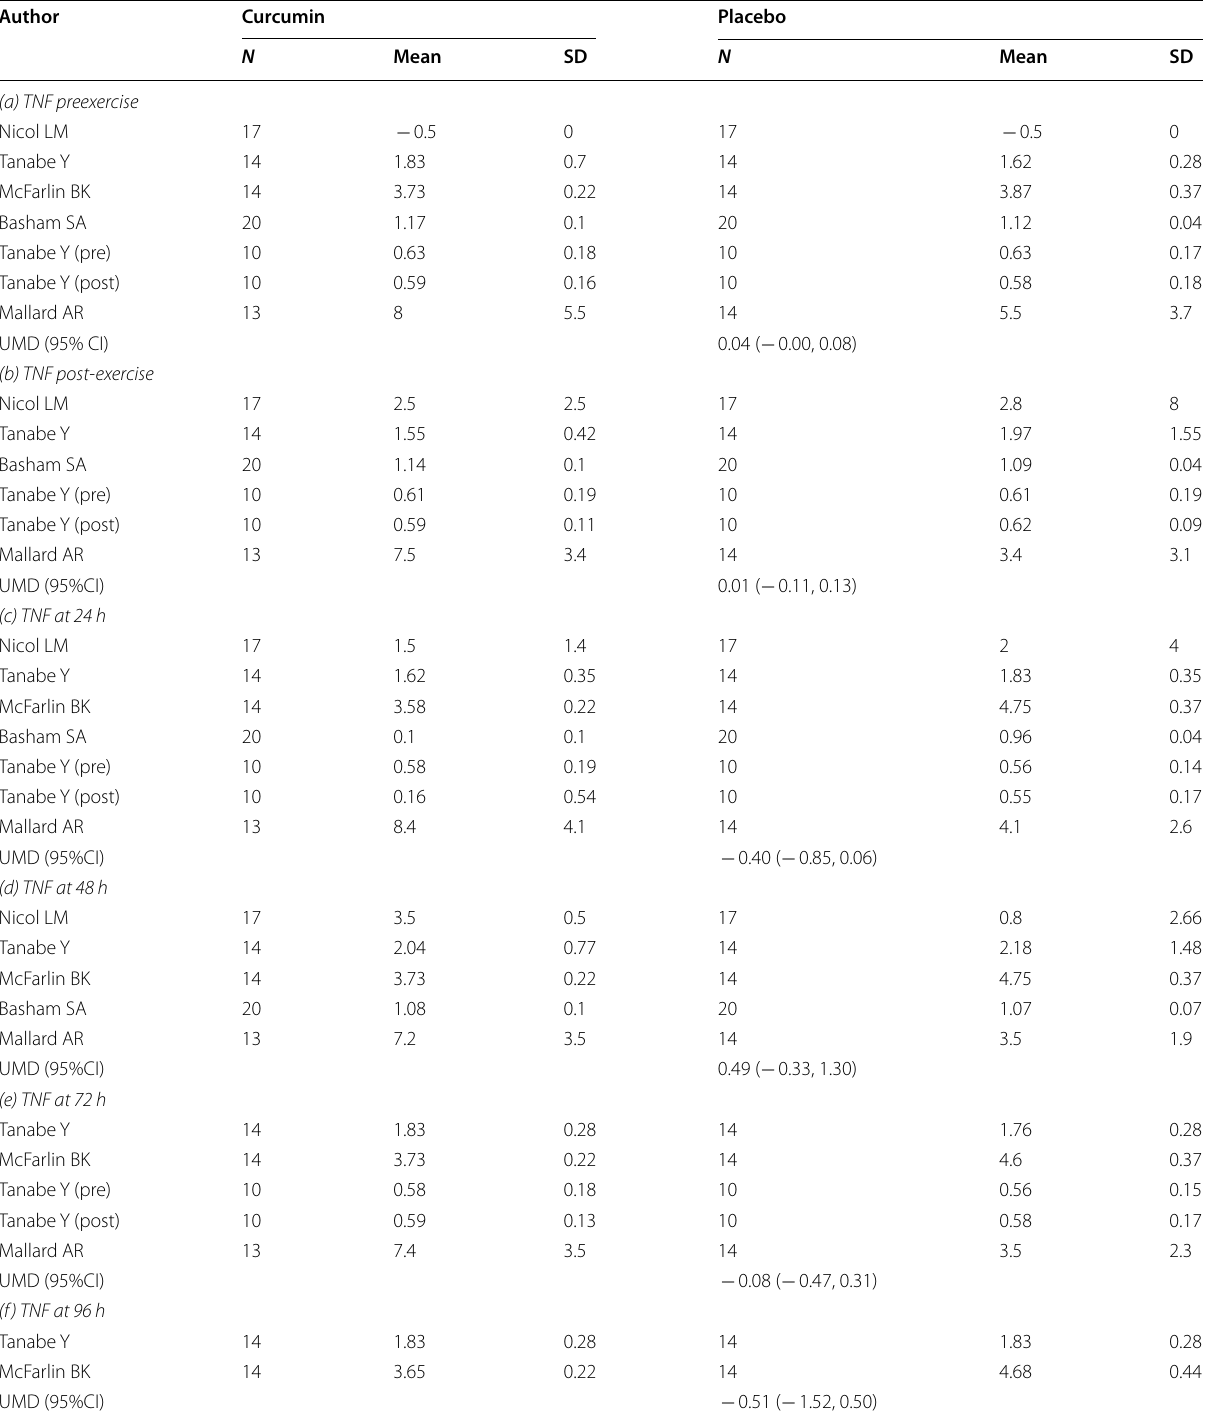
Table 5 Comparisons of TNF between curcumin supplement and